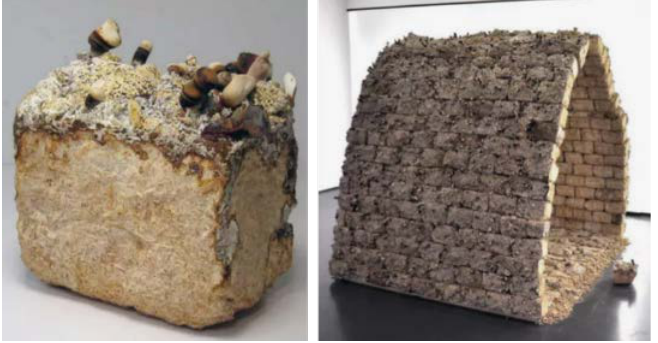
Figure 8 Mycotecture-2009